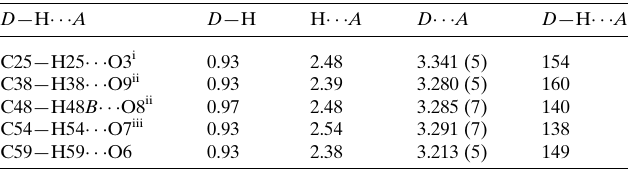
Table 1 Hydrogen-bond geometry (A˚ , (cid:4) ) for (I).